Question: Identify the chart type used in this figure.
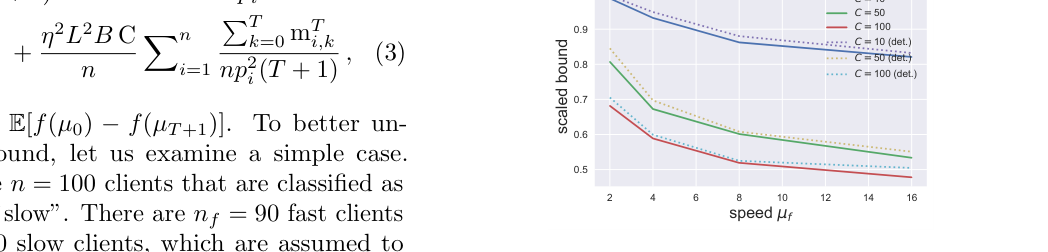
Answer: line